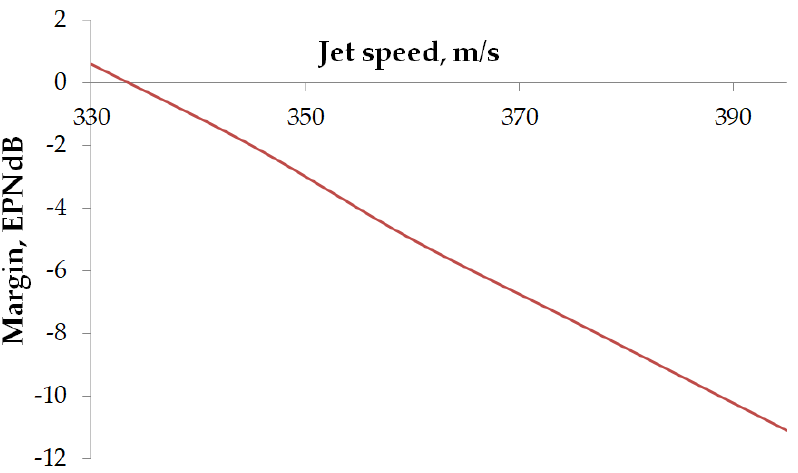
Figure 3. Noise margin with respect to Chapter 14 for different jet speeds at takeoff for the next-generation supersonic civil aircraft.